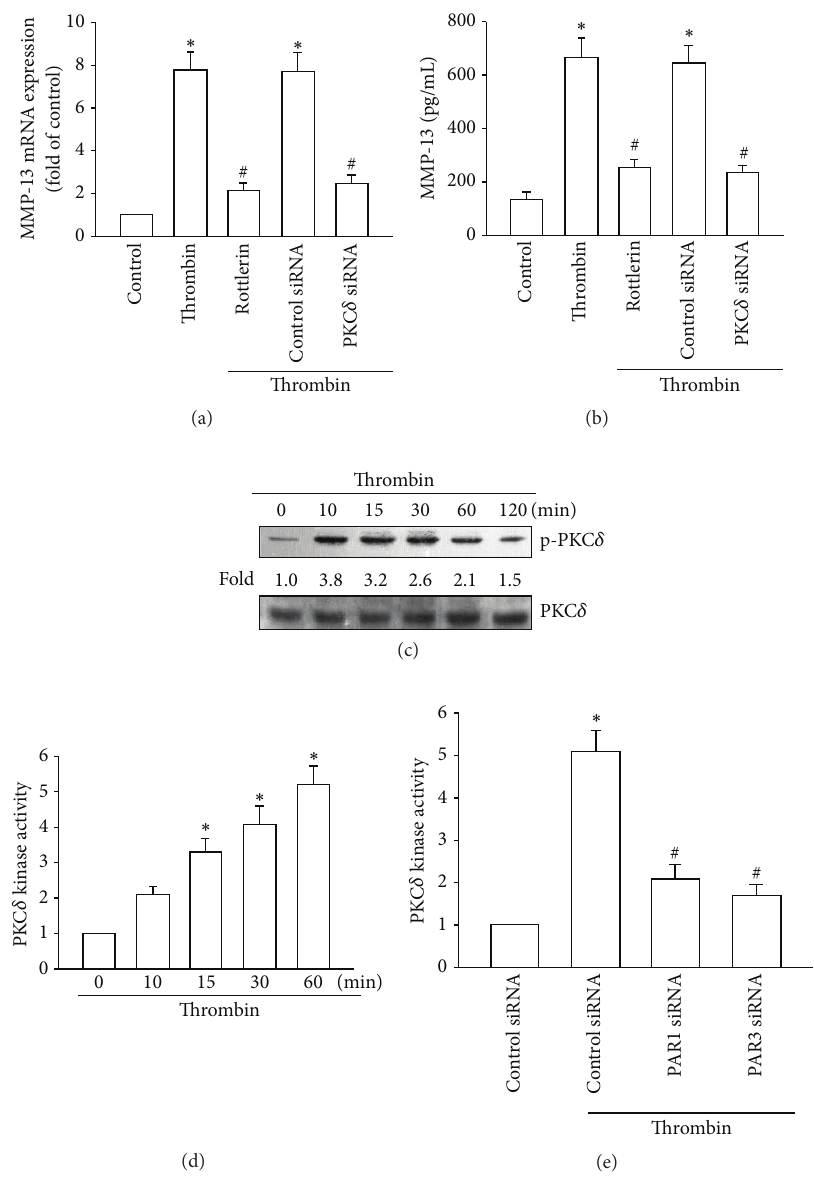
Figure 2: Role of PKC 𝛿 in thrombin-induced MMP-13 production. ((a) and (b)) qPCR and ELISA analyses of MMP-13 expression in chondrocytes, which were pretreated with rottlerin (3 𝜇 M) for 30 min or transfected with siRNA against PKC 𝛿 for 24h and then stimulated with thrombin for 24 h. ((c) and (d)) Western blotting analysis of phosphorylation and kinase activity of PKC 𝛿 in cells incubated with thrombin for the indicated time intervals. (e) Kinase activity of PKC 𝛿 in chondrocytes, which were transfected with siRNA against PAR1 or PAR3 for 24 h and stimulated with thrombin for 60min. ∗ 𝑃 < 0.05 as compared with basal levels. # 𝑃 < 0.05 as compared with the levels in the thrombin-treated